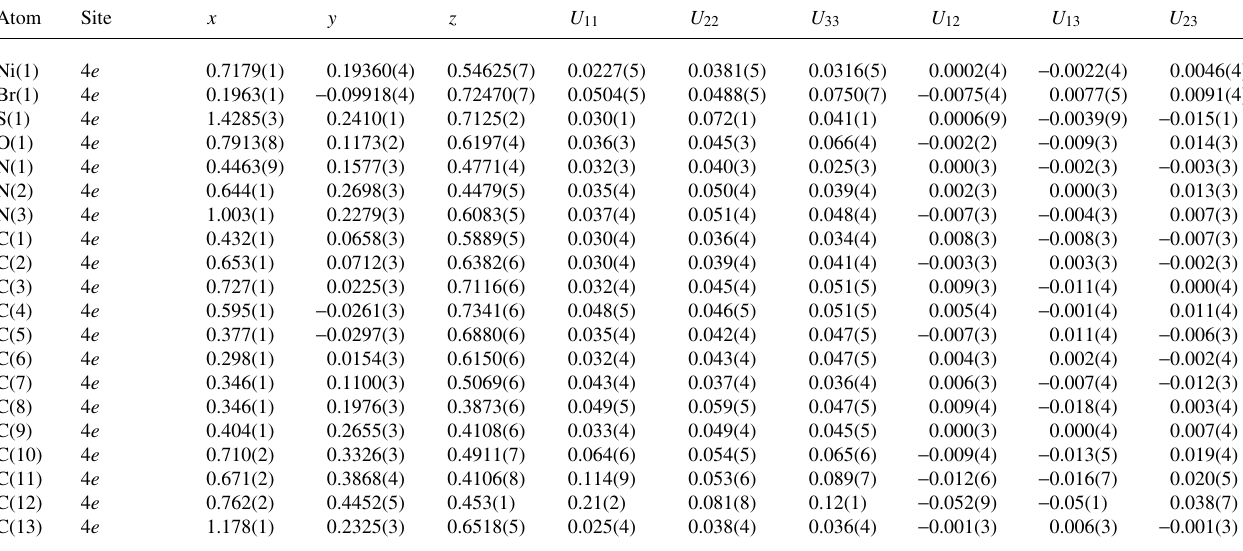
Table 3. Atomic coordinates and displacement parameters (in Å 2 )